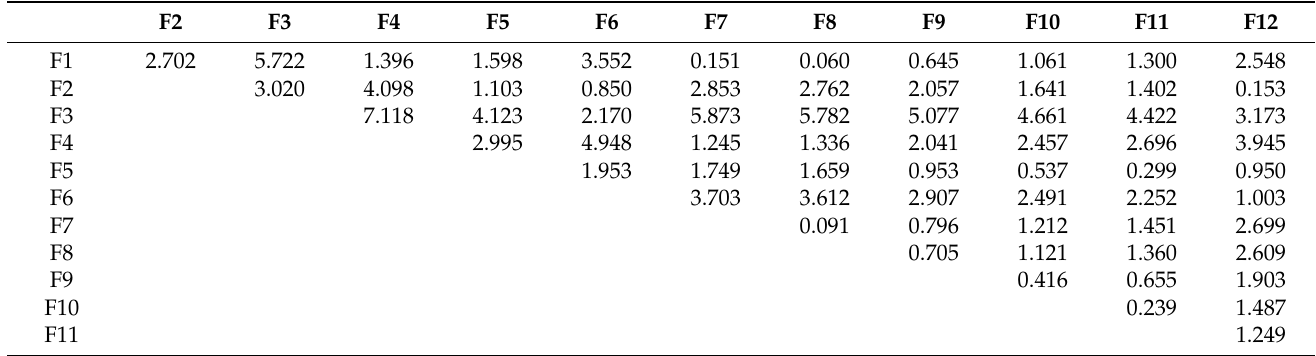
Table 2. The differences between means obtained from Tukey’s test; the value of HSD was 0.364.